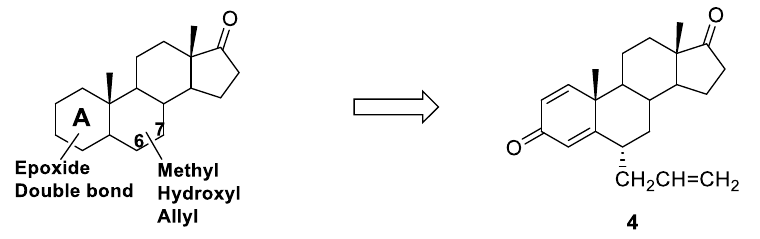
Figure 8. General structure of C6 or C7 substituted steroidal AIs able to fit into HA access channel and most potent compound of the series (4).